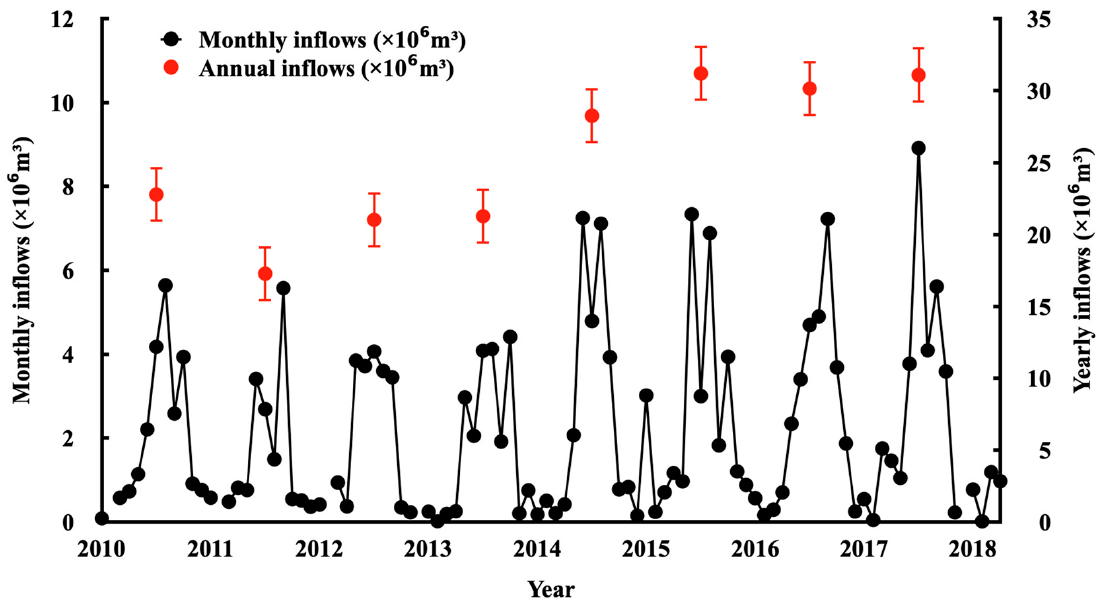
Figure 2. Calculated monthly inflows for January 2010–April 2018, represented by black solid circles and solid line (left Y axis), and yearly inflows ± standard error for 2010–2017, represented by red solid circles (right Y axis).